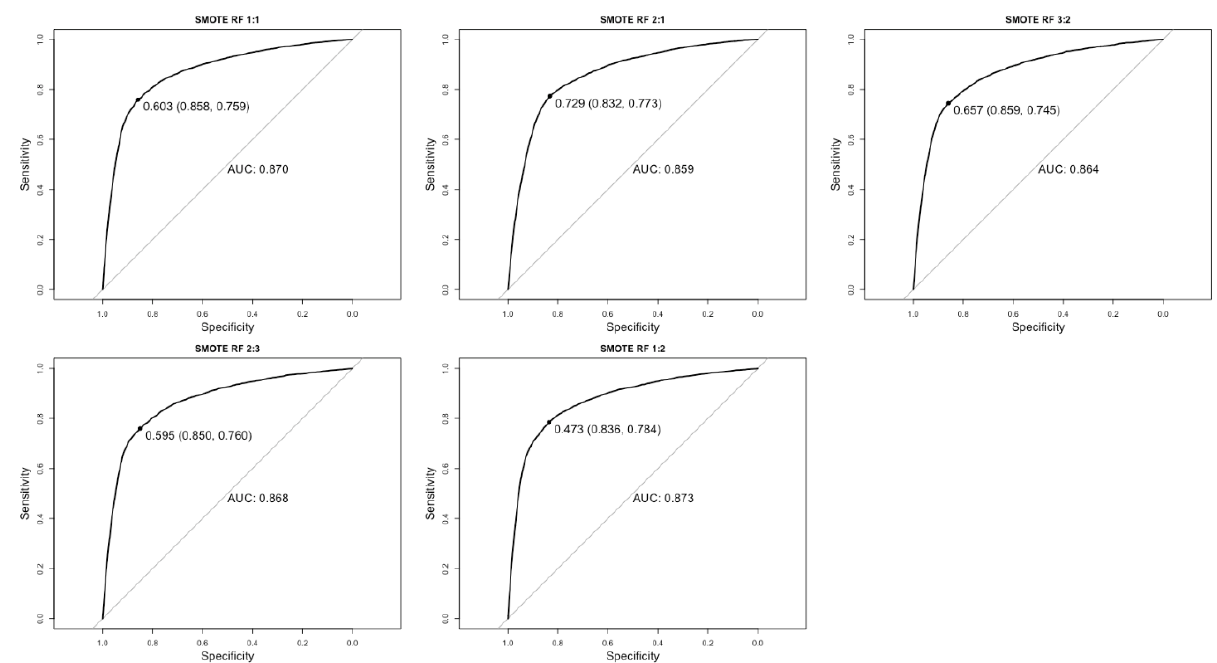
Figure 2. ROC curves for the five top performing algorithms. Random forest models trained using synthetic minority oversampling technique data at five sampling ratios. The diagonal line represents the AUC (Area Under Curve) of a random classifier.